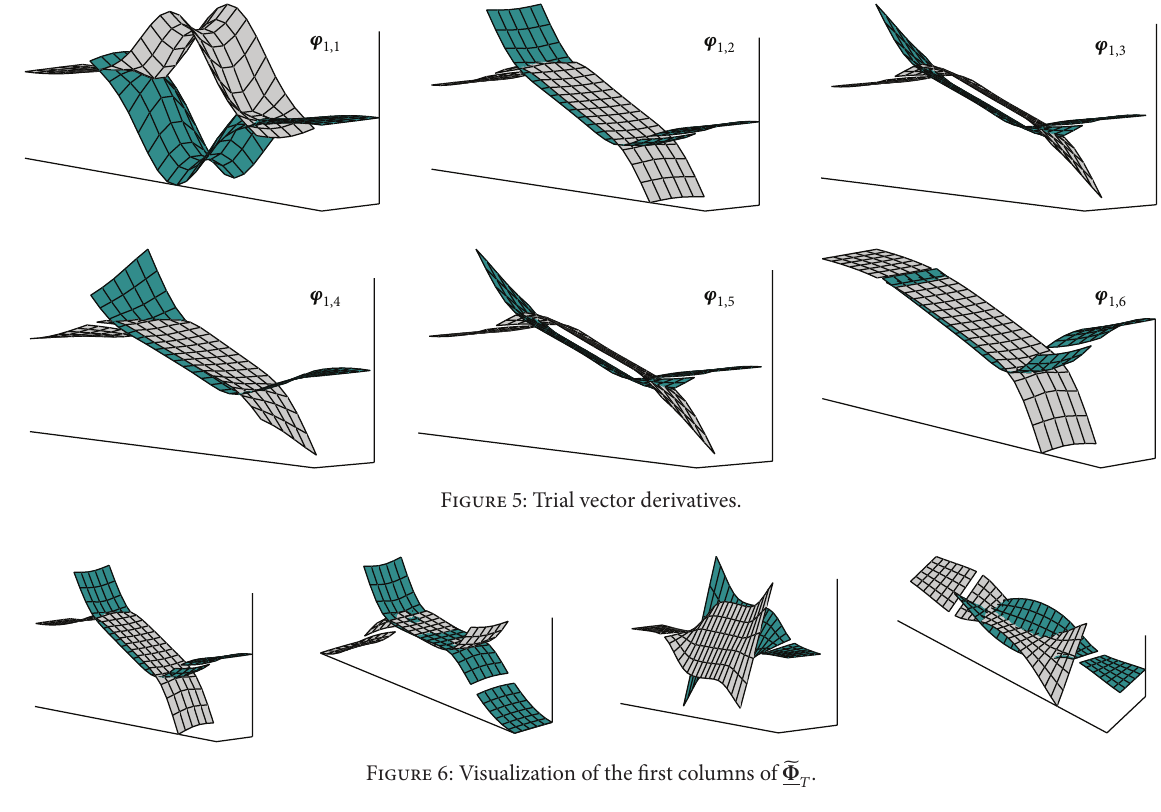
Figure 6: Visualization of the first columns of